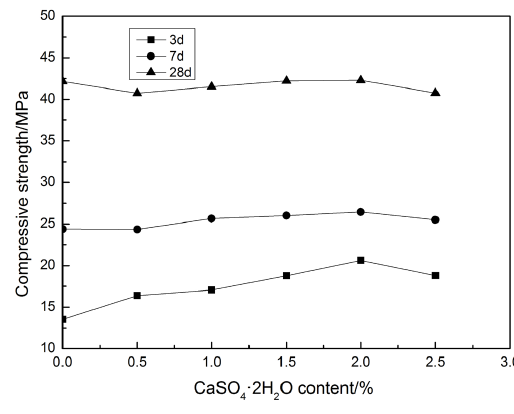
Fig. 3. Compressive strength of steel slag-cement binders with different CaSO